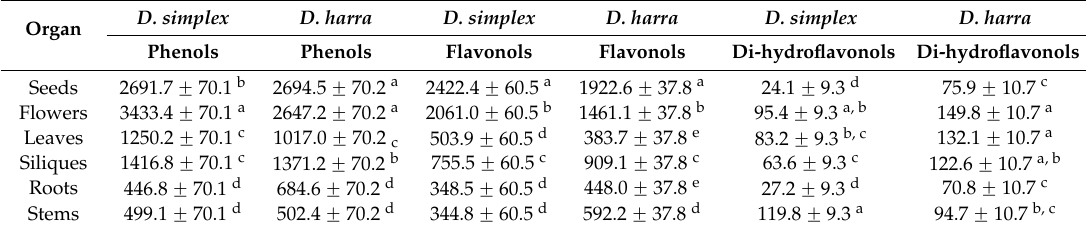
Table 1. Phenol content (mg caffeic acid equivalent/100 g, dry weight) found in plant extracts (mean ˘ standard